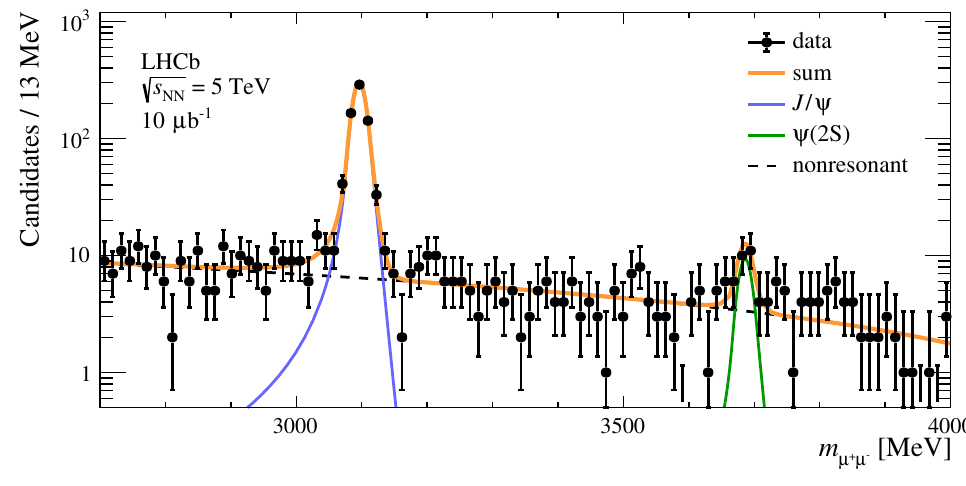
Figure 2 . The dimuon invariant mass spectrum in the range between 2 . 7 and 4 . 0 GeV . The contribution of J/ψ (solid purple line) and ψ (2 S ) (solid dark green line) mesons, and non-resonant background (dashed black line) are shown individually along with the sum of all contributions (solid orange line).